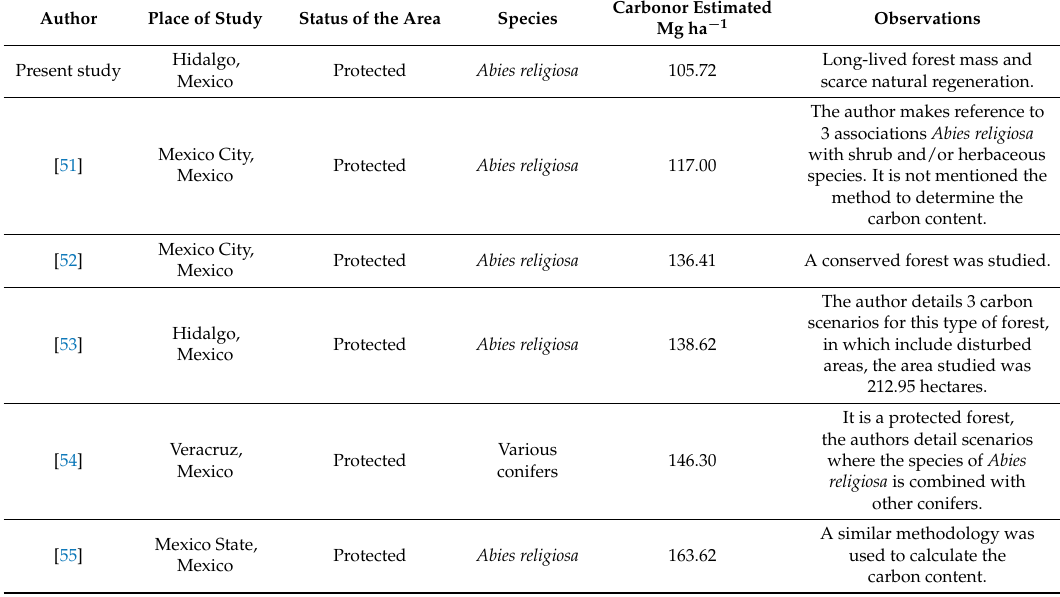
Table 5. Comparison of studies in protected forests where they have calculated the carbon content in aerial biomass in Abies religiosa